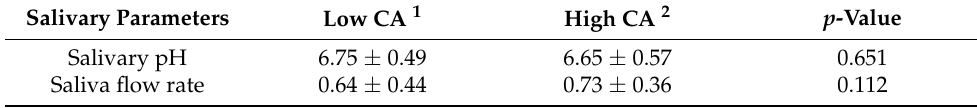
Table 1. Comparison of salivary pH and salivary flow rate according to the significant caries index. Salivary